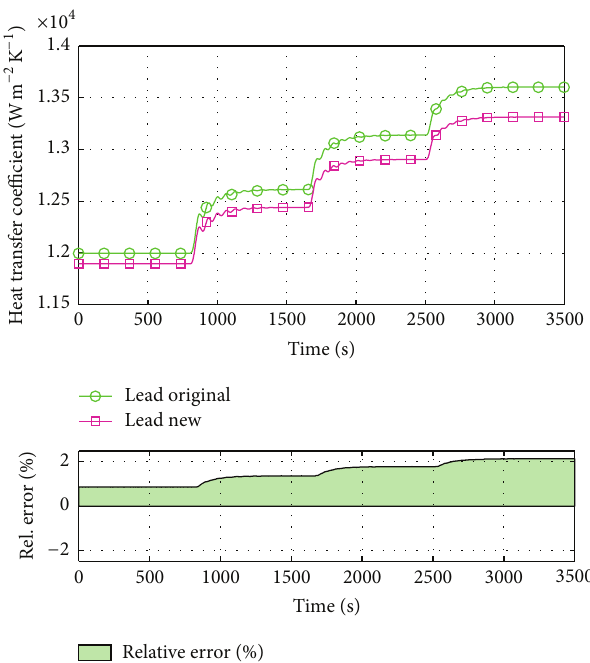
Figure 29: Lead heat exchanger heat transfer coefficient, original versus new “tpf”